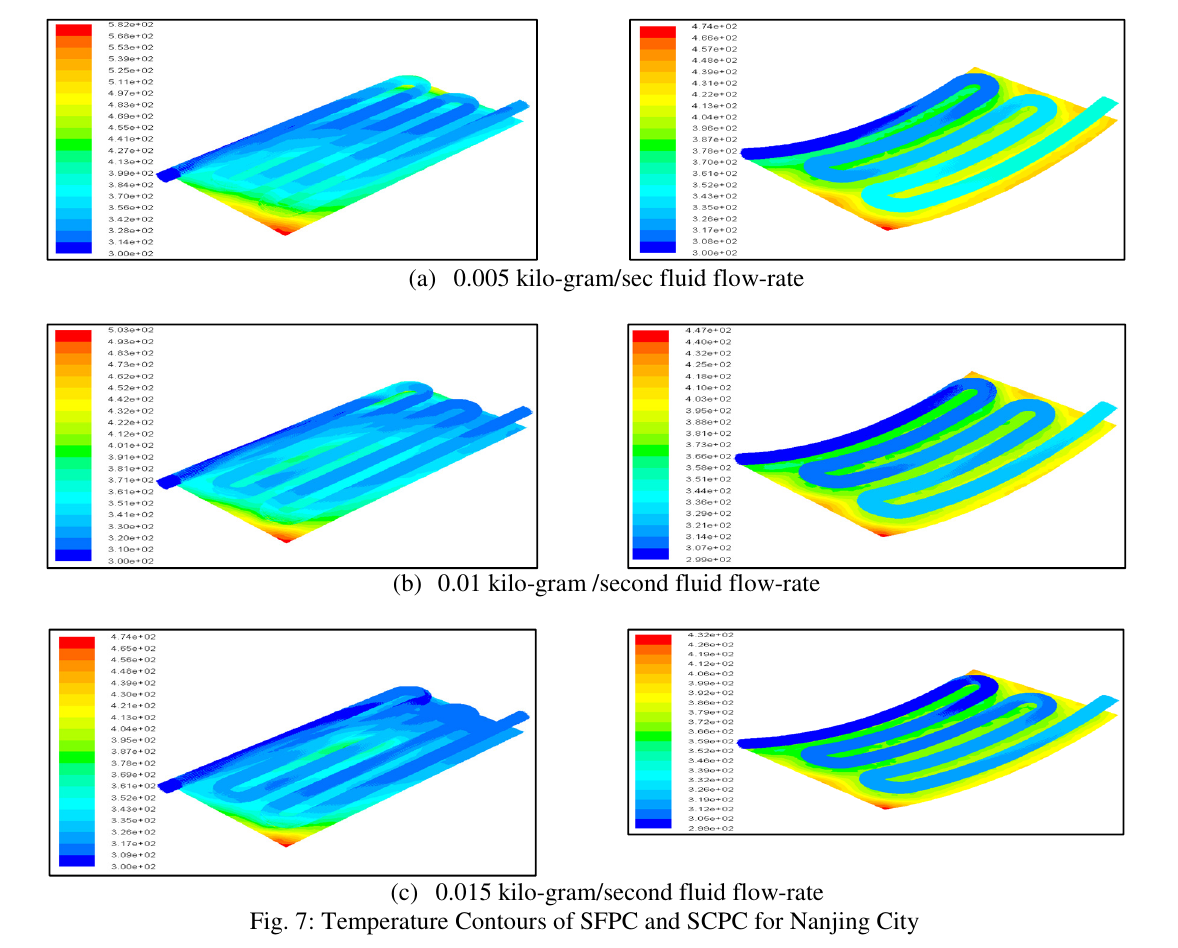
Fig. 7: Temperature Contours of SFPC and SCPC for Nanjing